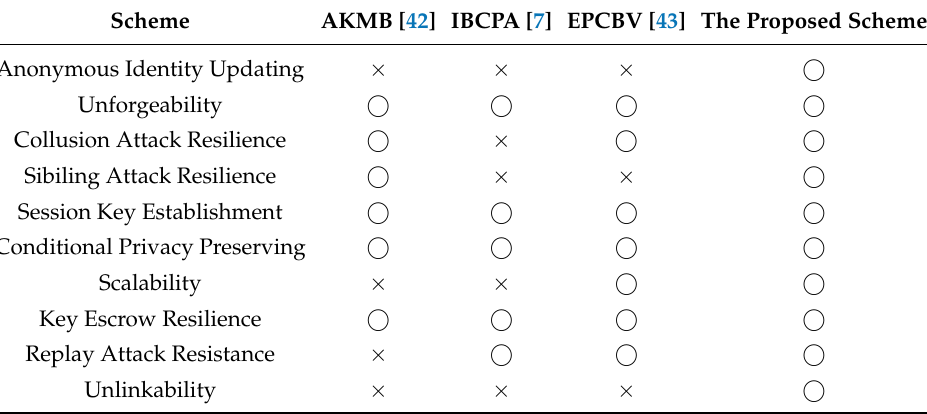
Table 3. Comparison Results on Security Properties.